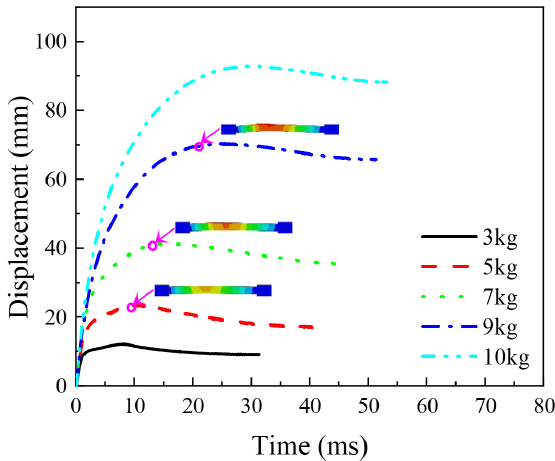
Figure 18. Displacement–time curves of the prefabricated shear wall without defects under different explosive equivalent